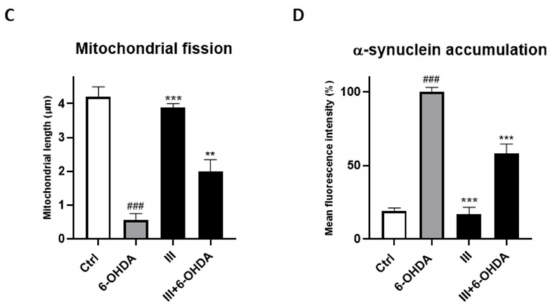
Figure 7. Effect of fraction III (6 µ g/mL) on α -synuclein accumulation ( A , D ) and mitochondrial fission ( B , C ), evaluated by anti- α -synuclein antibody and Mitotracker Red CMXRos, respectively, via confocal microscopy on SH-SY5Y cells treated with 6-OHDA (50 µ M). Quantitative analysis was conducted on ImageJ, version 1.47. Data are expressed as mitochondrial length ( µ m) ( C ) or mean fluorescence intensity ( D ). Scale bars: 10 µ m. N ≥ 30. Results are showed as mean ± standard deviation (SD) from three independent experiments. ### denotes p < 0.001 vs. Ctrl; **, *** denote p < 0.01 and p < 0.001 vs.